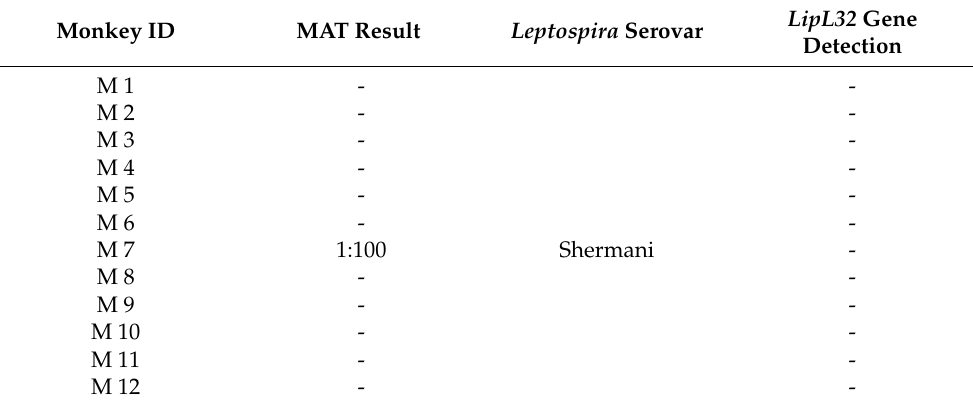
Table 1. MAT and PCR results of Leptospira spp. infection of wild long-tailed